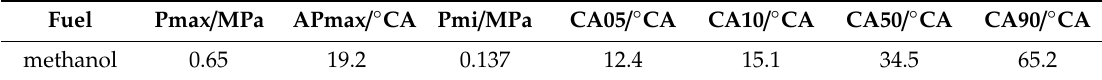
Table 3. Characteristic parameters of methanol